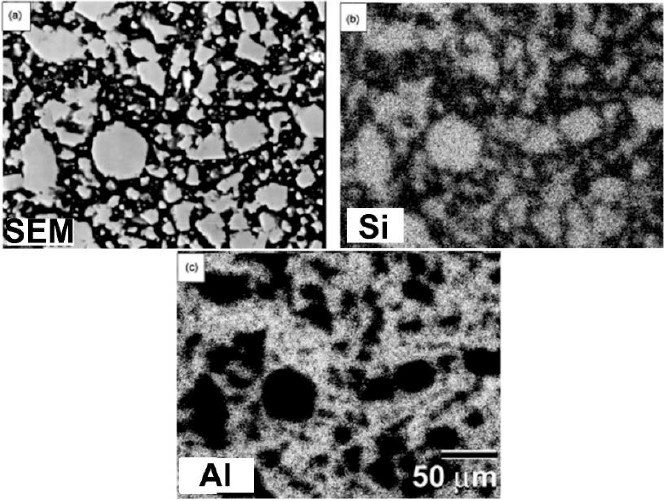
Figure 19. ( a ) SEM micrograph, elemental mapping of ( b ) Si, and ( c ) Al for as-consolidated SiC 10 /Al 90 that was ball milled for 86 ks.